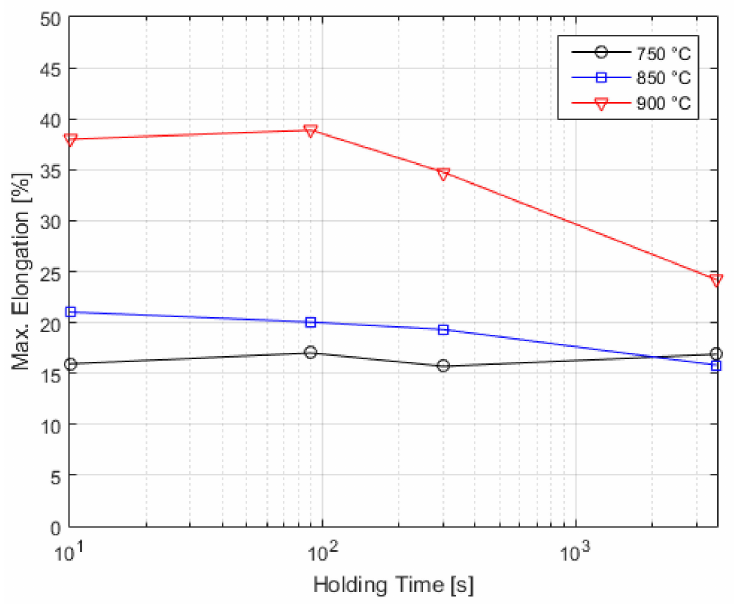
Figure 6. Maximal elongation reached at each different temperature and holding time.